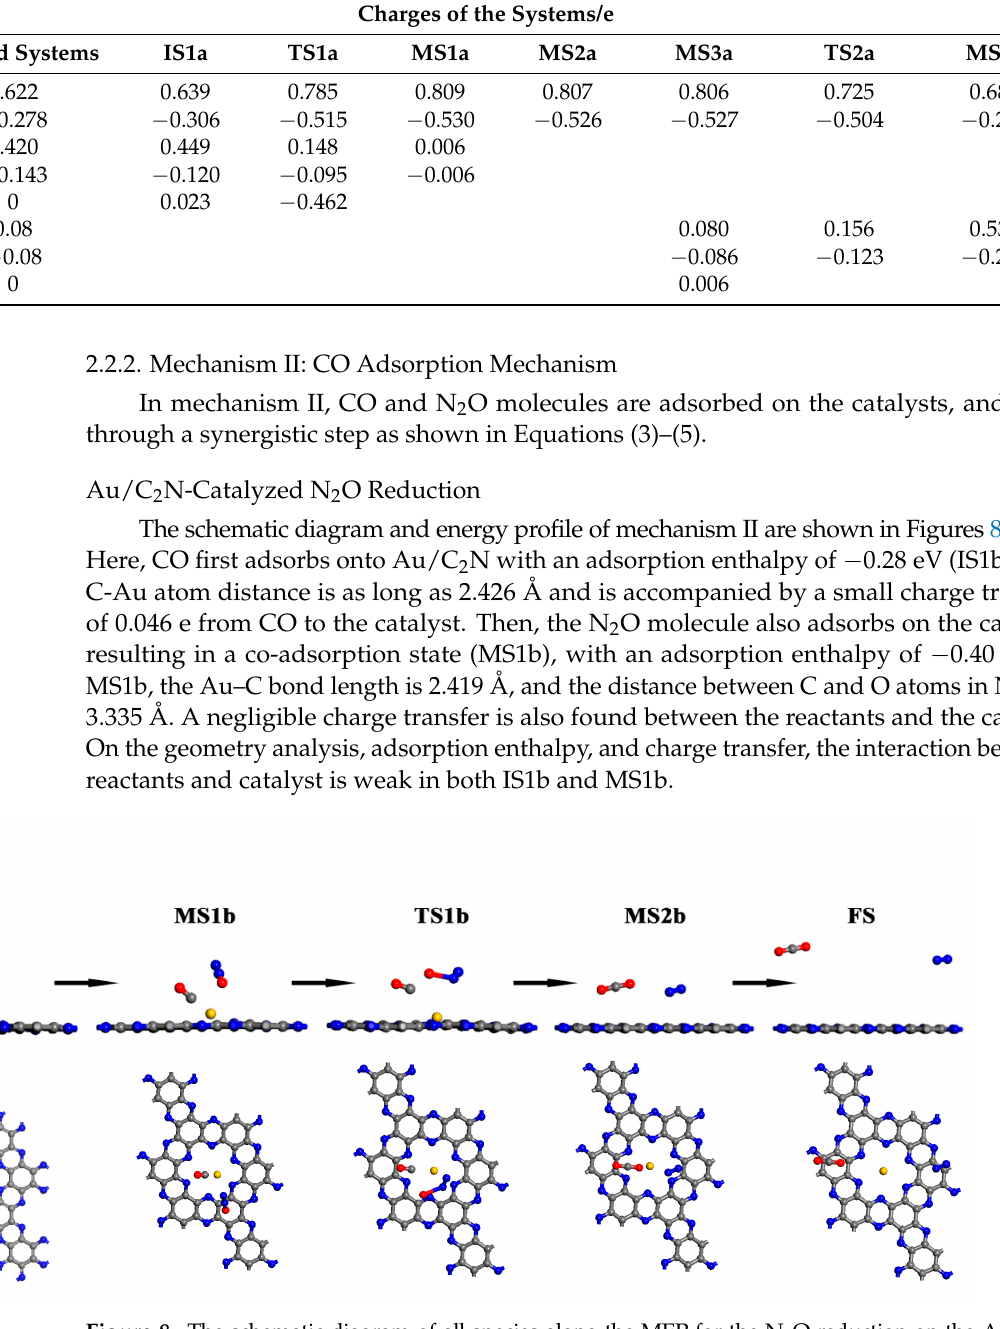
Figure 8. The schematic diagram of all species along the MEP for the N 2 O reduction on the Au/C 2 N monolayer via mechanism II. (Blue, grey, yellow and red balls represent N, C, Au and O atoms, respectively.)